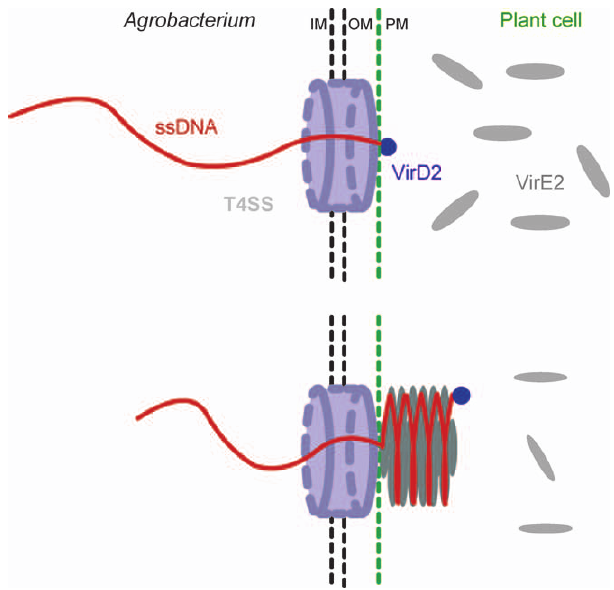
Figure 5. Model of T-DNA Translocation into the Plant Host Cell Transferred ssDNA-VirD2 is exported out of the bacterium through a Type IV secretion system (T4SS, light blue) and reaches the host cell cytoplasm. There, the cooperative arrangement of VirE2 into a helical structure actively pulls the incoming T-DNA into the plant cell cytosol. Additionally, the large speed of polymerization ( ; 1 l m/s) mediates a fast protection of the T-DNA at the very moment it enters the host cytosol. IM: inner membrane, OM: outer membrane, PM: plasma membrane.